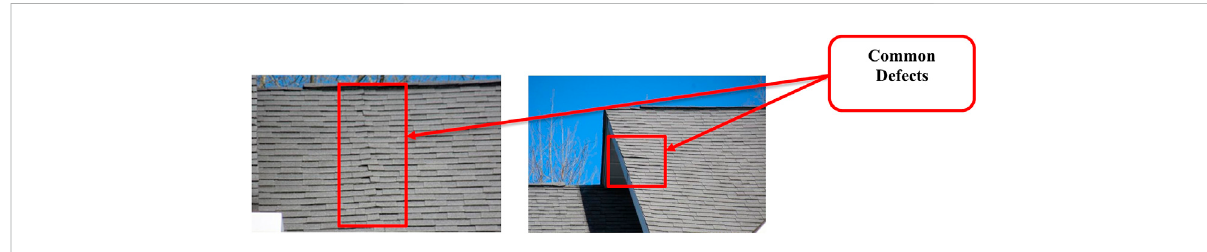
FIGURE 3 Common defects identi fi ed on the manually composed aerial images.